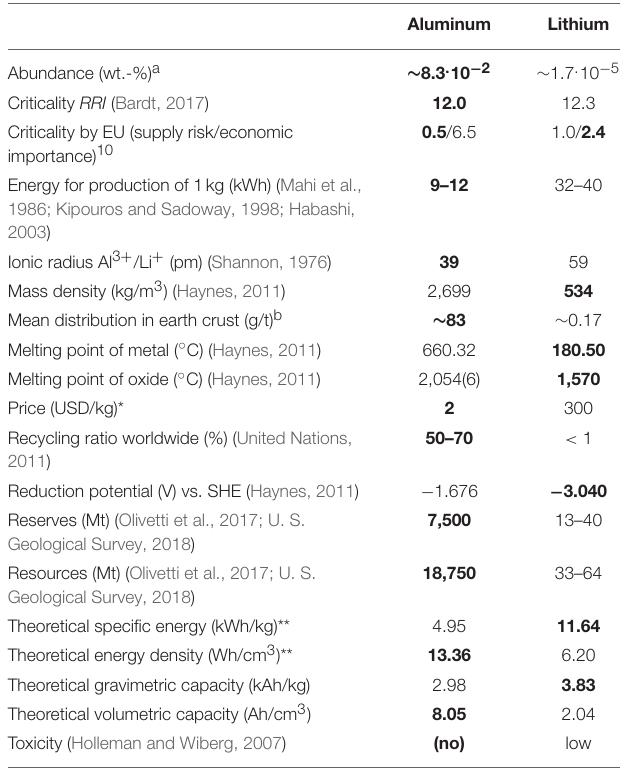
TABLE 1 | Comparison of characteristics of aluminum with lithium, the benchmark element (the bold marked numbers indicate advantageous